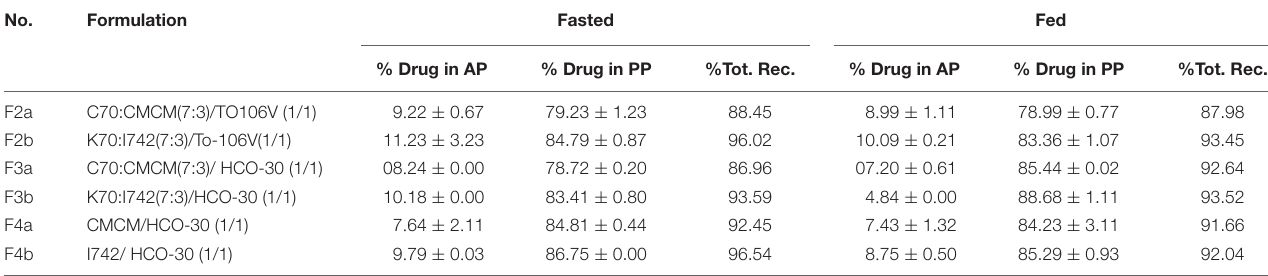
TABLE 5 | % fenofibrate in aqueous phase (AP) and pellet phase (PP) after 30 min digestion under fed and fasted condition, ( n = 3 ± SD). No. Formulation Fasted Fed % Drug in AP % Drug in PP %Tot. Rec. % Drug in AP % Drug in PP %Tot.